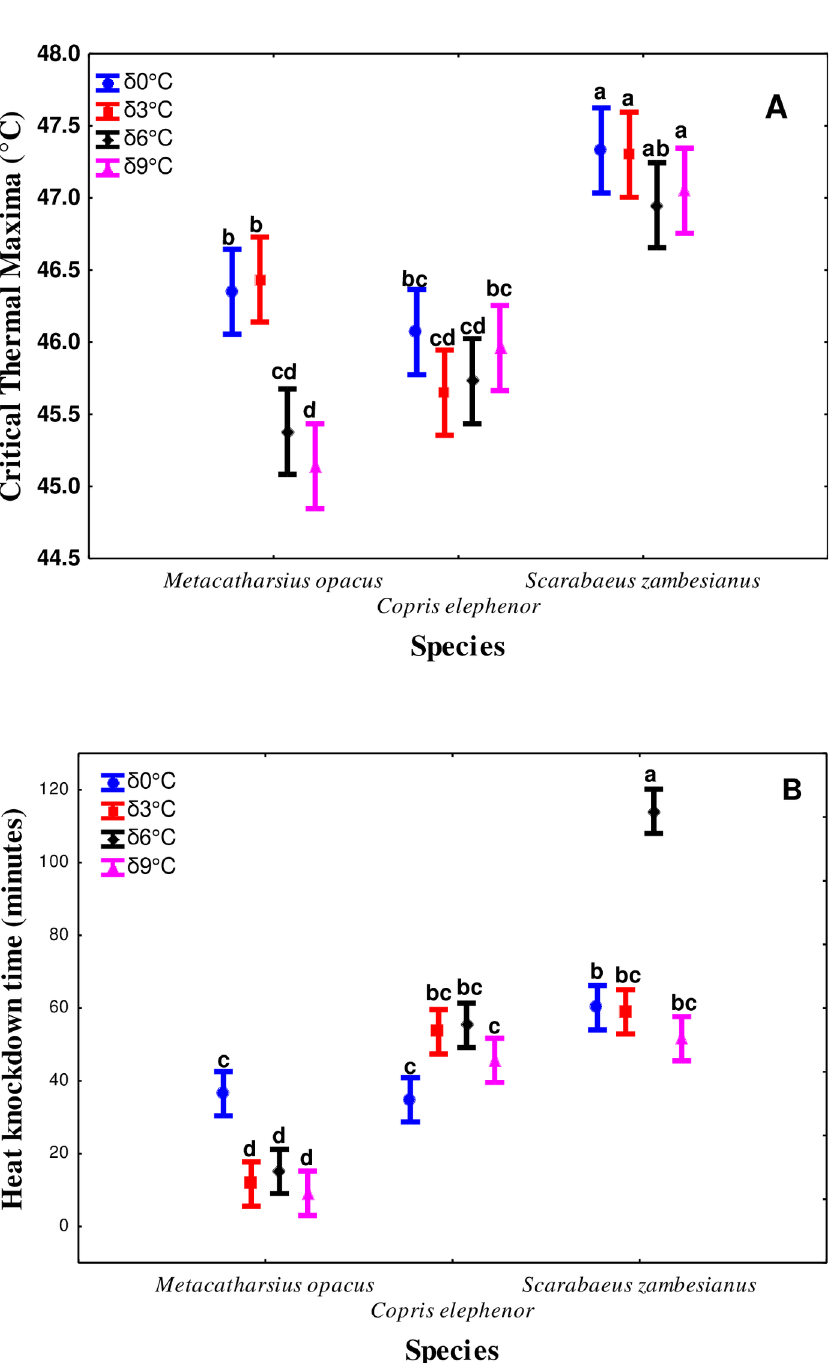
Fig 2. Effect of temperature fluctuation (acclimation at temperatures pulsating around a benign of 27˚C: 0 = δ 0˚C (unacclimated), 3 = δ 3˚C, 6 = δ 6˚C and 9 = δ 9˚C) on (A) Critical thermal maxima and (B) Heat knock down time for M . opacus , C . elphenor and S . zambesianus . Vertical bars denote ±95% confidence limits. Means with the same letter are not statistically